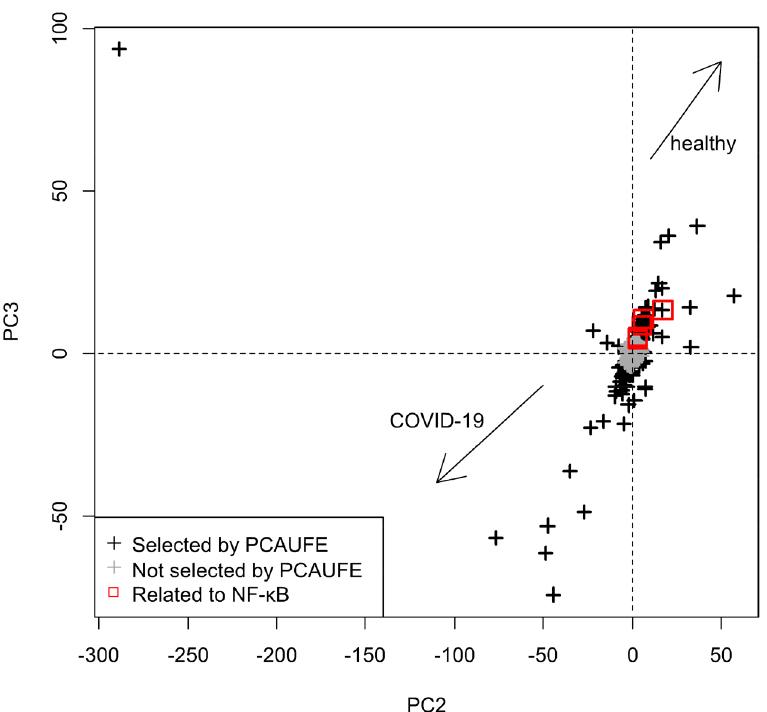
Figure 5. Scatter plot of the PC2 and PC3 scores for data set 1. The black crosses represent the probes selected by PCAUFE, while the gray crosses represent unselected probes. The red squares are associated with the five overlapping genes in Fig.